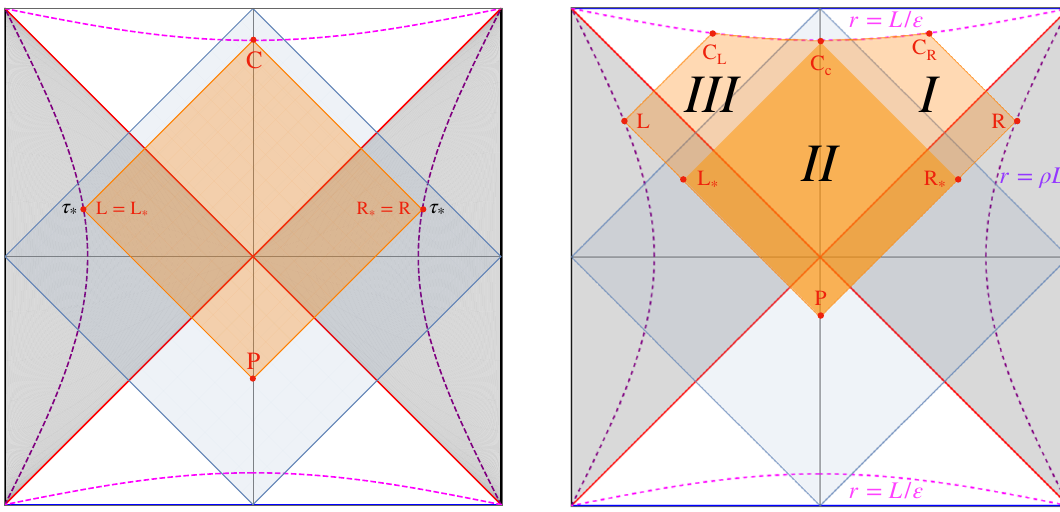
Figure 6 . The orange region represents the WdW patch with a cut-off surface at r = L/ε . Left: the WdW patch at the transition time, i.e., τ = τ ∗ . Right: the WdW patch after the transition time where we divide it into three subregions as shown, with I, III shaded light orange and II , dark